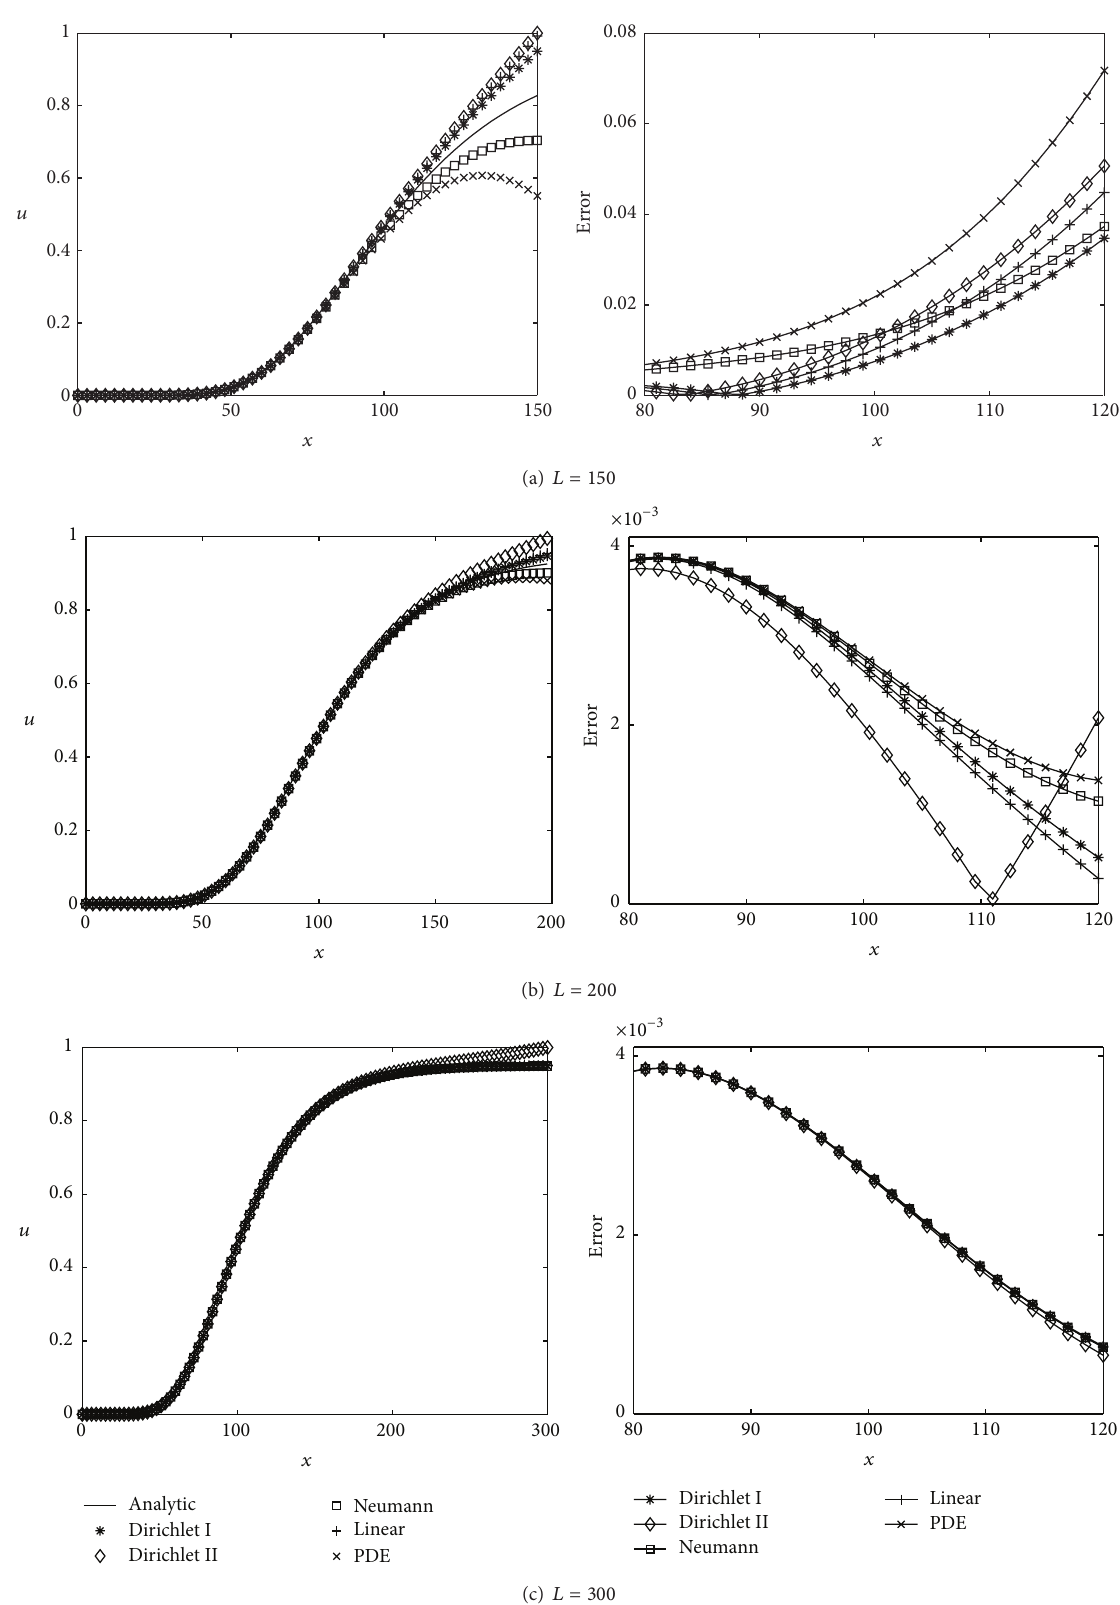
Figure 4: Comparison of cash-or-nothing option values (left column) and pointwise error (right column) with five BCs on different domain: (a) 𝐿 = 150 , (b) 𝐿 = 200 , and (c) 𝐿 = 300 ,